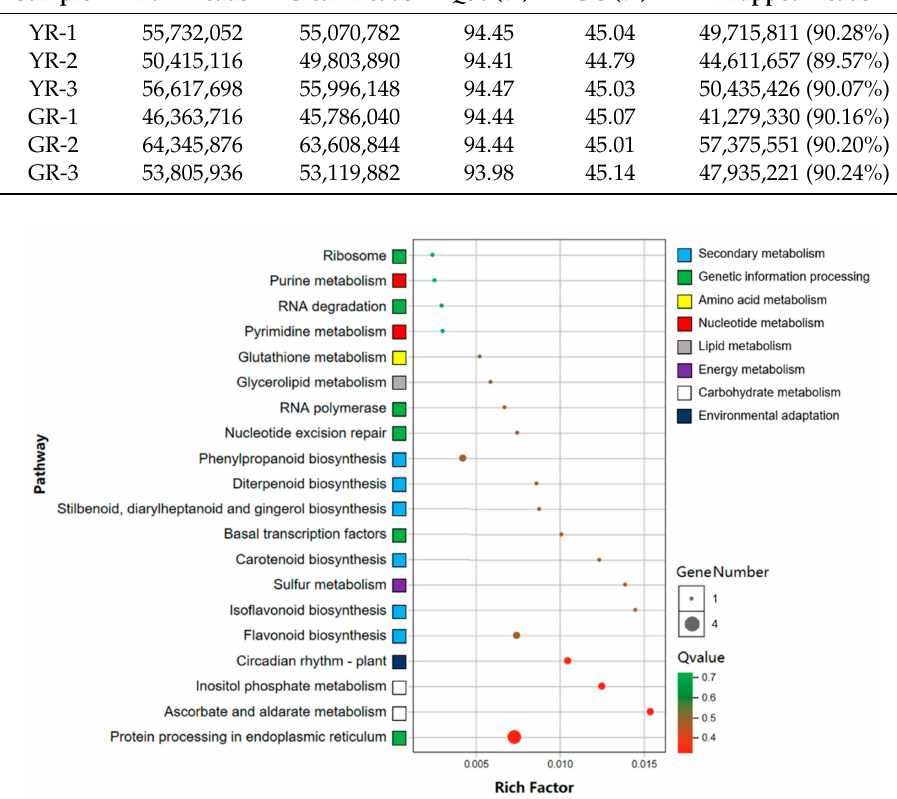
Figure 4. Top 20 KEGG pathways enriched in